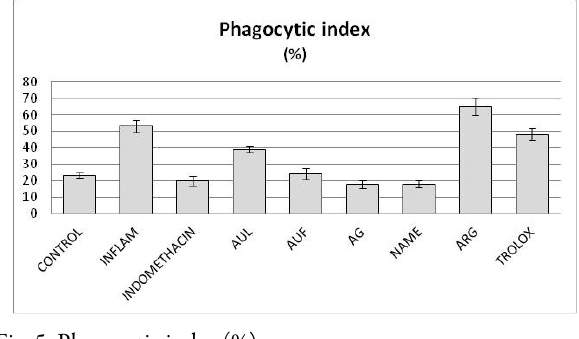
Fig. 5. Phagocytic index (%)